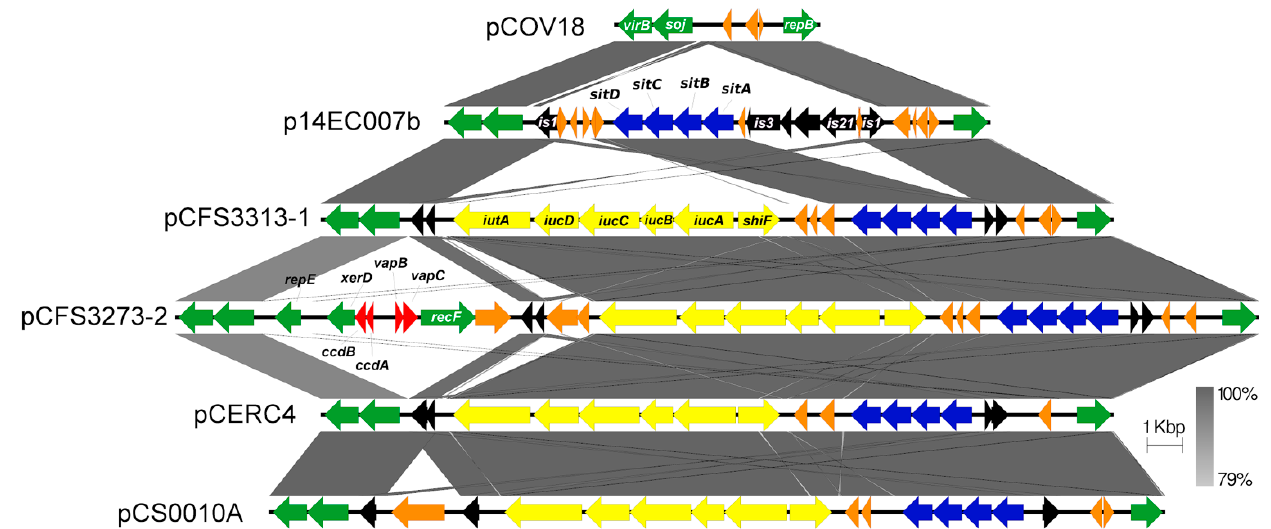
Figure 6. Siderophore units identified in plasmids pCFS3313-1 and pCFS3273-2. Highlighted in the figure are four selected BLAST hits—plasmids pCOV18, p14EC007b, pCERC4, and pCS0010A. The first two plasmids show a high level of similarity in the flanking regions while the latter two show similarity across the siderophore containing units along with the flanking regions. Colour scheme: siderophore (yellow), metal transporters (blue), transposons and insertion elements (black), toxins/antitoxins (red), and genes of interest (green). Other genes are represented in orange.